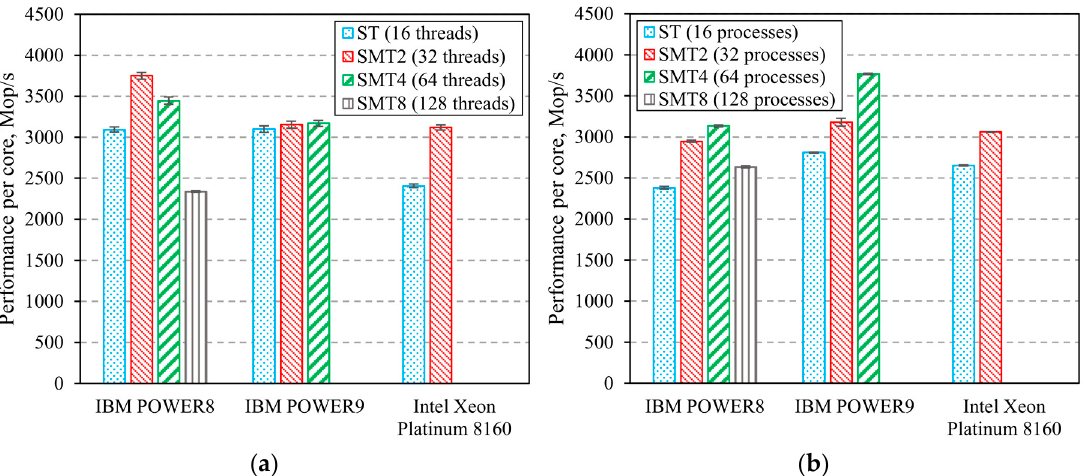
Figure 4. LU benchmark results: OpenMP version ( a ) and MPI version ( b ).